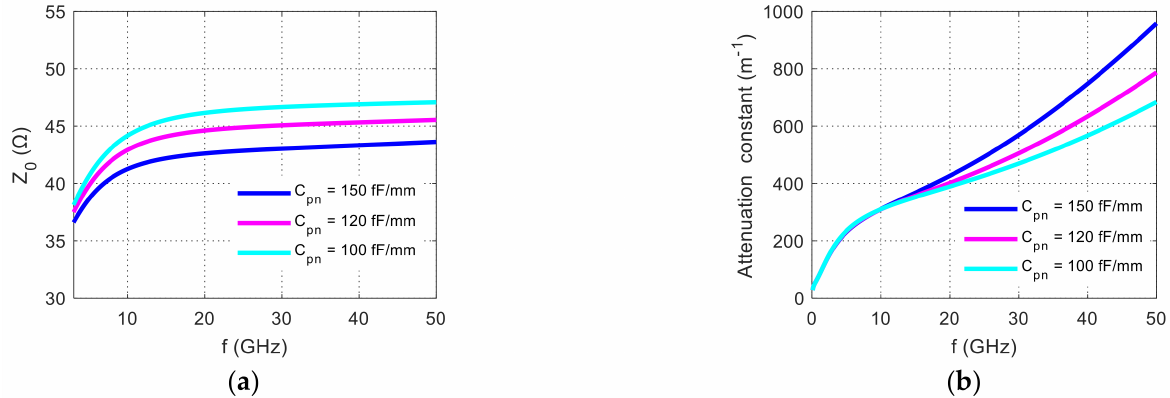
Figure 10. Simulation results of ( a ) total impedance and ( b ) total power attenuation constant varying with the junc- tion